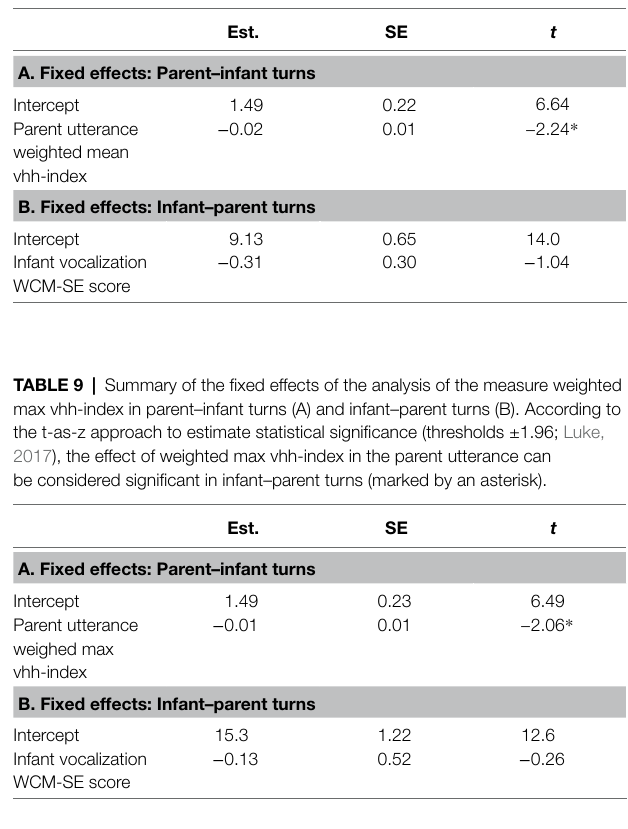
TABLE 8 | Summary of the fixed effects of the analysis of the measure weighted mean vhh-index in parent–infant turns (A) and infant–parent turns (B). According to the t-as-z approach to estimate statistical significance (thresholds ±1.96; Luke, 2017), the effect of weighted mean vhh-index in the parent utterance can be considered significant in infant–parent turns (marked by an asterisk).